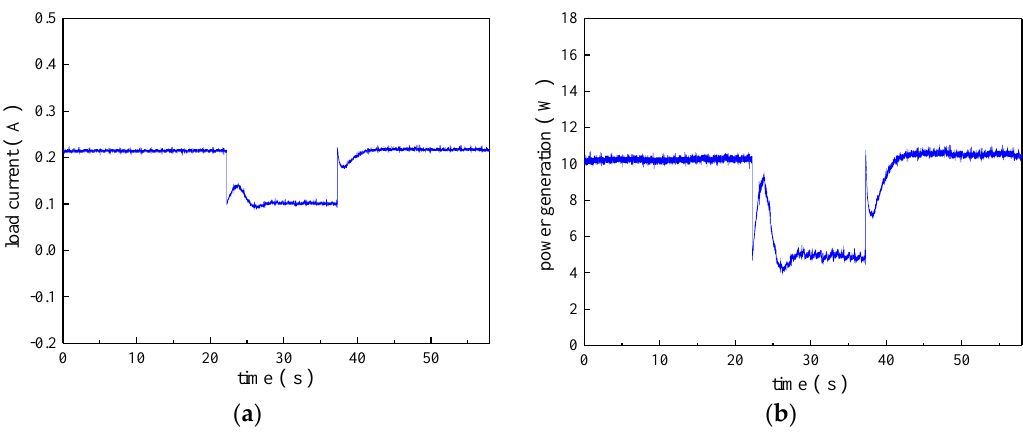
Figure 20. Output current waveform and power generating waveform with variable load during generating test: ( a ) output current waveform; and ( b ) power generating waveform.